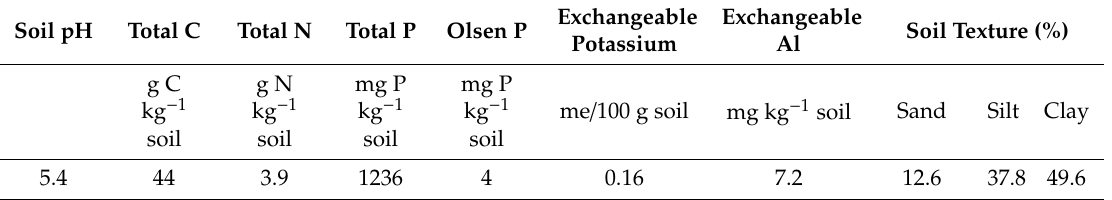
Table 2. Basic physiochemical properties of the Waikiwi soil used in the study. Soil pH Total C Total